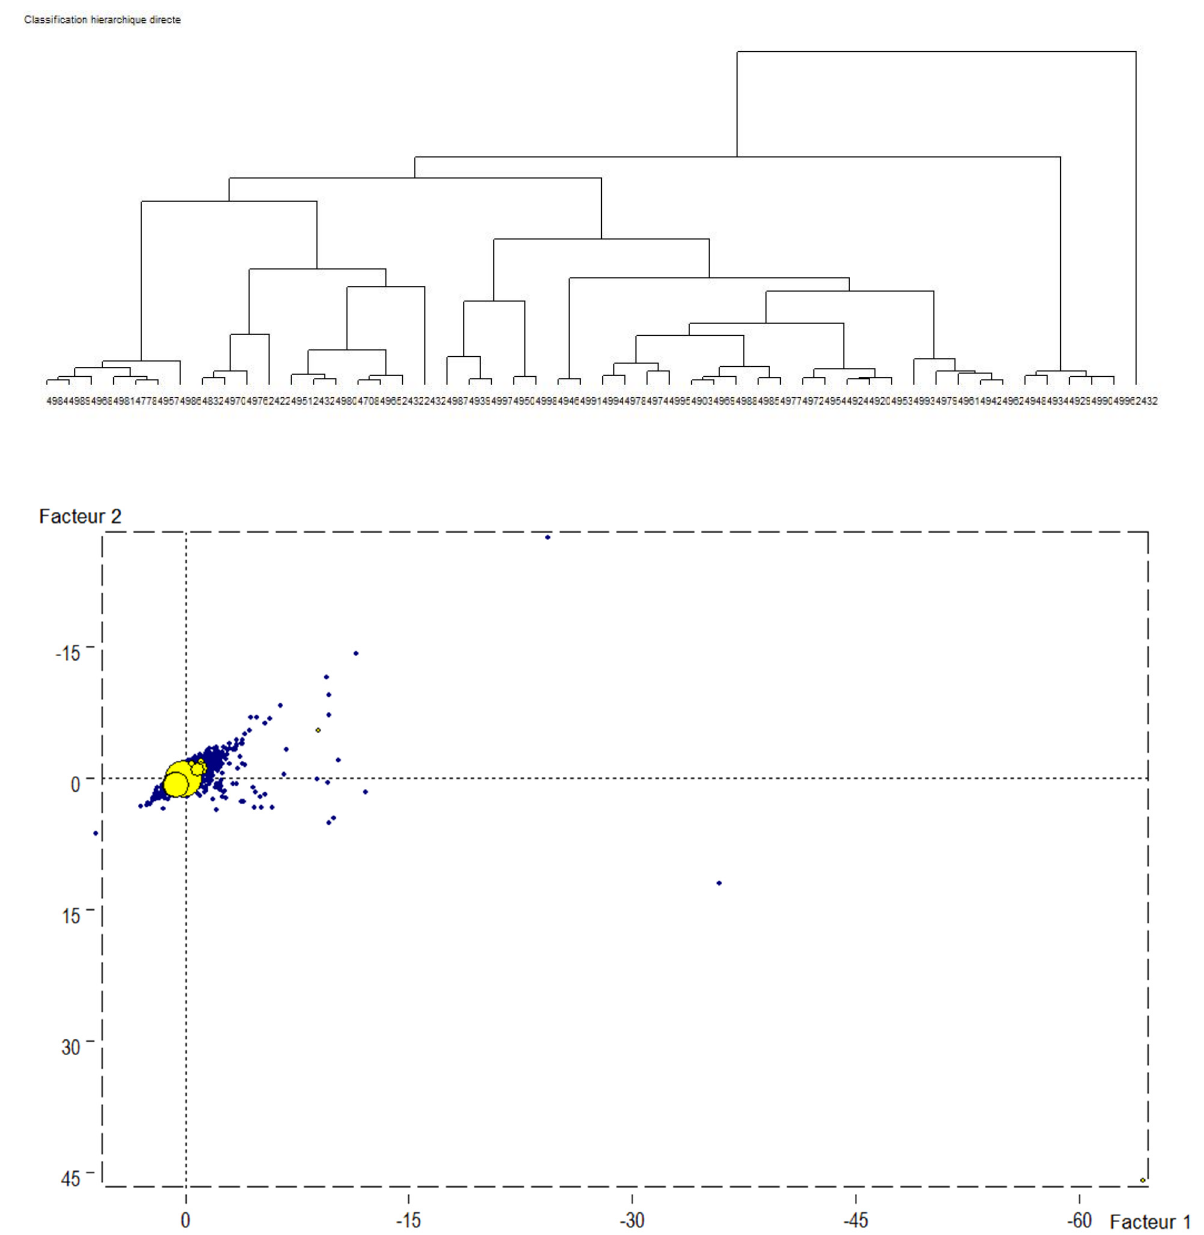
Figure A2. Cluster analysis dendrogram and graph for the northeast geographic distribution.